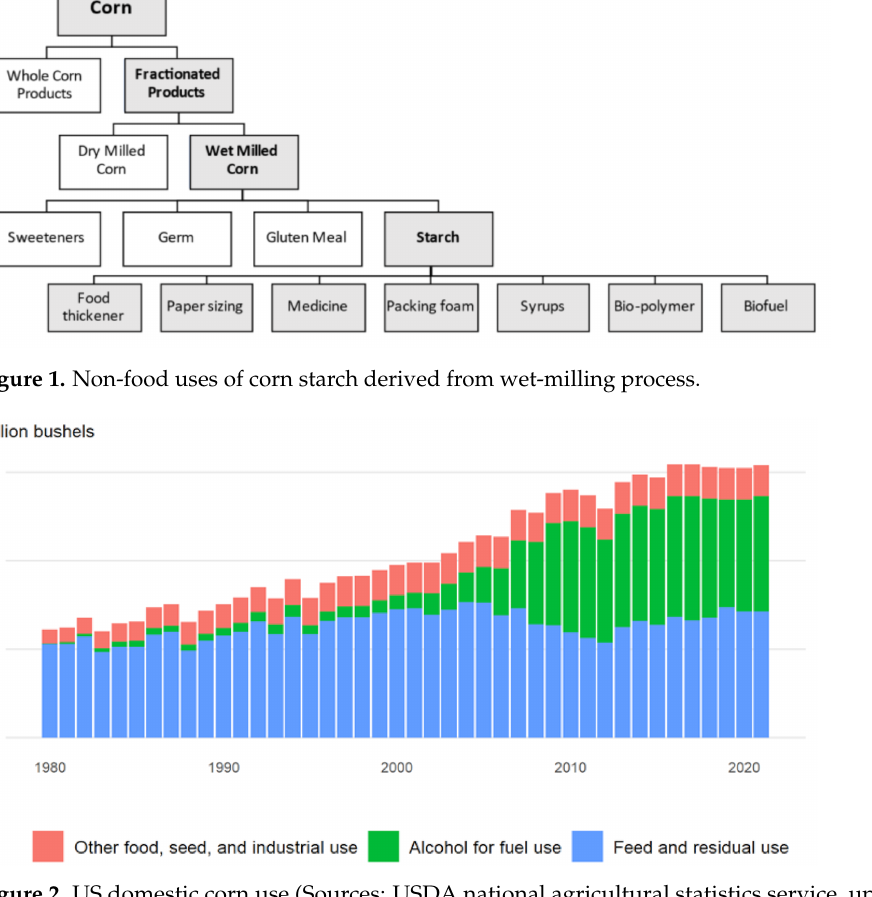
Figure 2. US domestic corn use (Sources: USDA national agricultural statistics service, updated in July 2021: http://www.nass.usda.gov/, accessed on 27 November